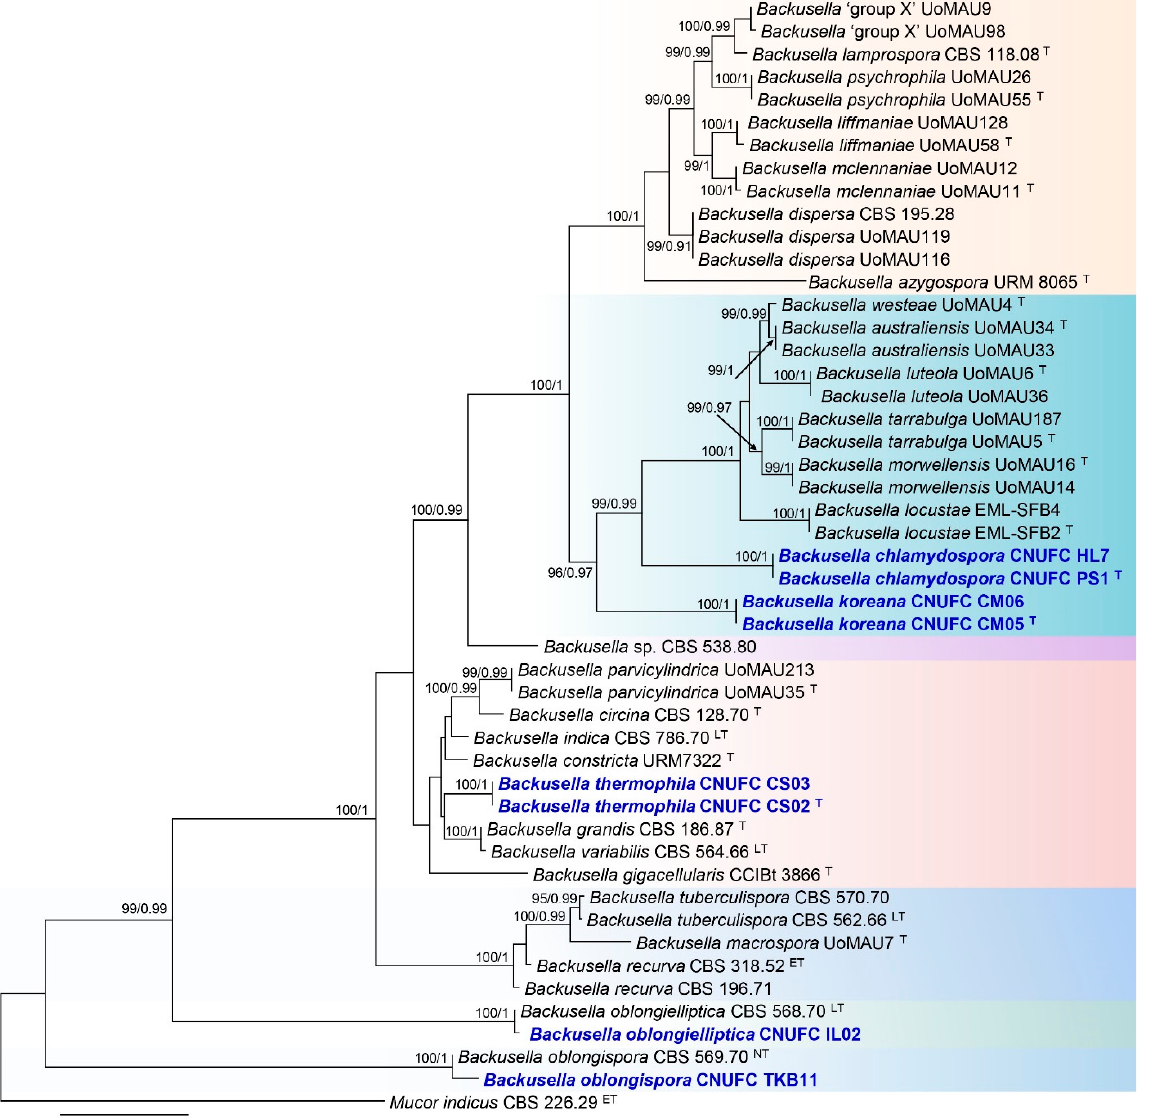
Figure 2. Phylogenetic tree constructed by maximum likelihood analysis of 49 sequences of the combined ITS and LSU. The numbers above branches represent maximum likelihood bootstrap percentages (left) and Bayesian posterior probabilities (right). Bootstrap values ≥ 70% and Bayesian posterior probabilities ≥ 0.90 are shown. The bar indicates the number of substitutions per position. Mucor indicus CBS 226.29 was used as outgroup. Ex-type, ex-epitype, ex-lectotype, and ex-neotype strains are marked with T , ET, LT , and NT , respectively. Newly generated sequences are in bold blue.